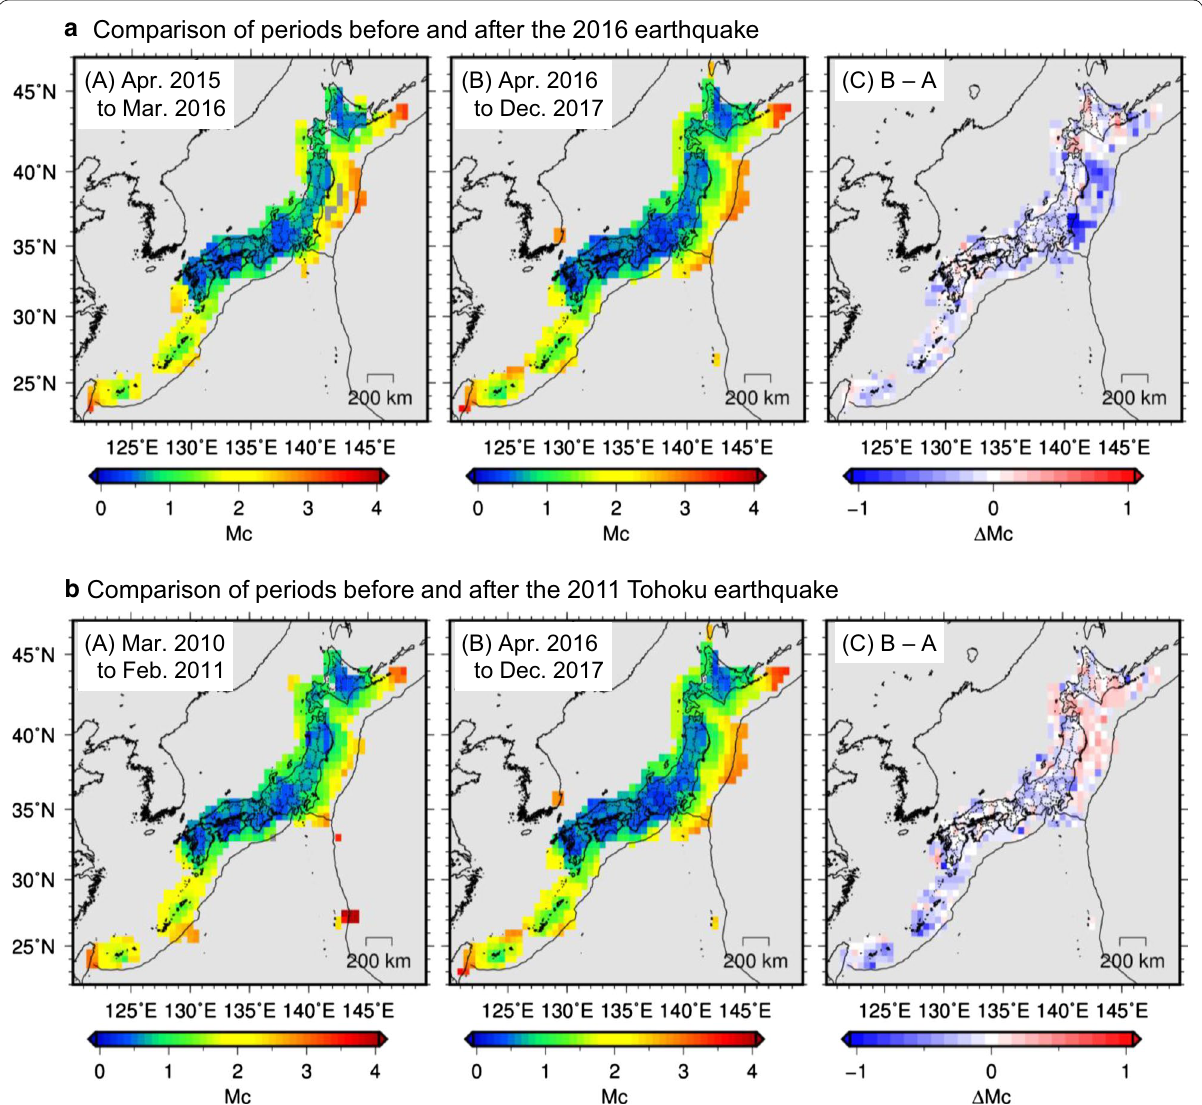
Fig. 4 Distribution of completeness magnitude ( M c ); depth range 0–50 km. a Comparison of the periods April 2015 to March 2016 and April 2016 to December 2017, before and after the introduction of the automatic process. b Comparison of March 2010 to February 2011 and April 2016 to